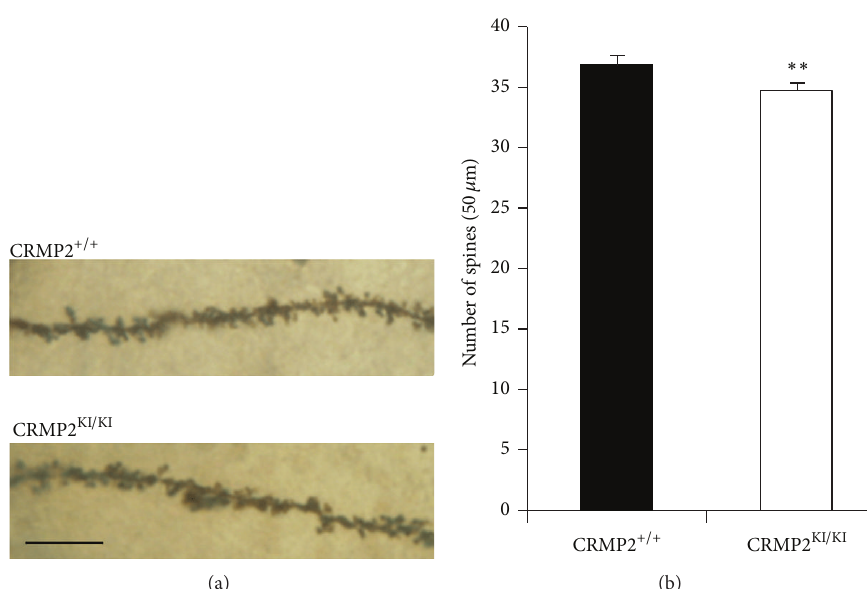
Figure 2: Reduction of dendritic spine density in hippocampal CA1 pyramidal neurons in CRMP2 KI / KI mice at P18. (a) Representative photographs of dendritic segments of hippocampal CA1 pyramidal neurons at P18. Scale bar, 10 𝜇 m. (b) Reduced dendritic spine density was observed in hippocampal CA1 pyramidal neurons of CRMP2 KI / KI mice compared to those of control mice. 50 neurons in each area from three mice in each genotype were analyzed. ∗ 𝑃 < 0.05 .